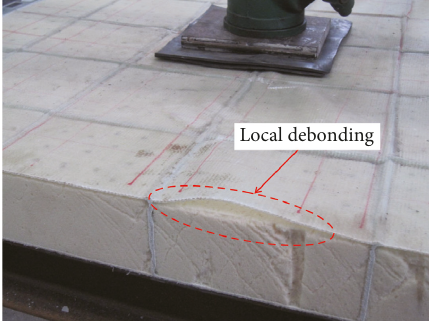
Figure 8: Failure mode of specimen